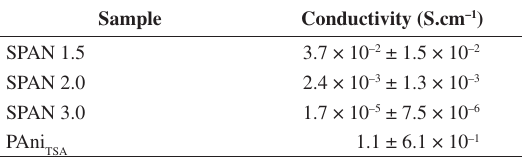
Table 1. Electrical conductivity of PAni samples sulfonated in different molar ratios of sulfur and nitrogen (S/N) and PAni